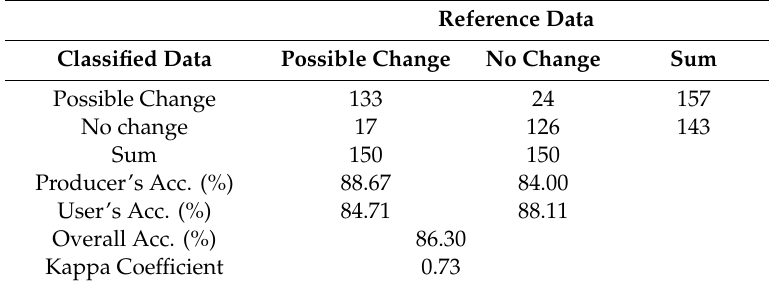
Table 8. The accuracies of transfer learning for sample selection used in Method 2 and Method 3.